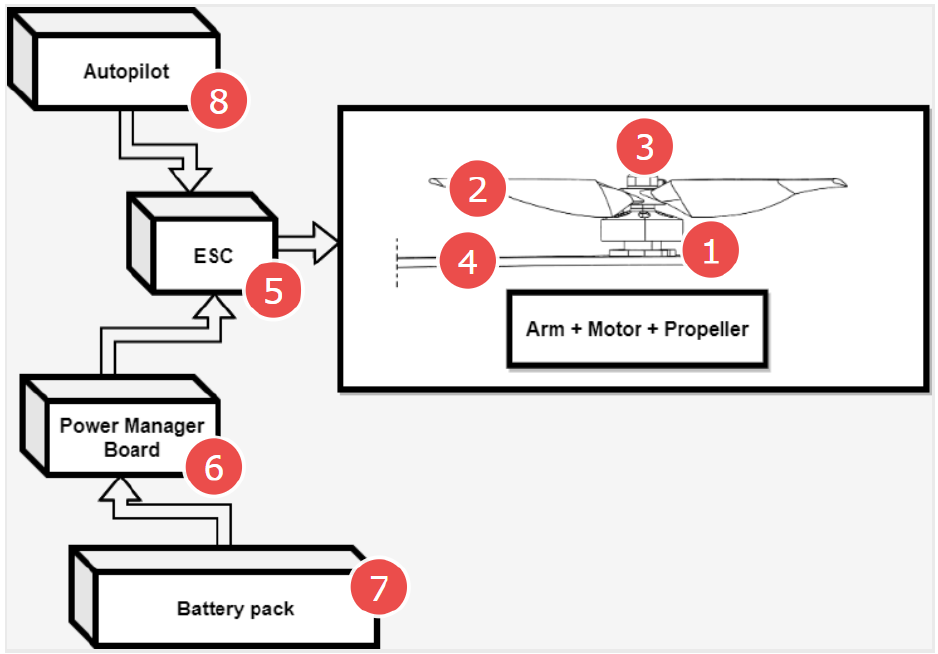
Figure 1. Multicopter propulsion system scheme and potential failure sources (1—Electric